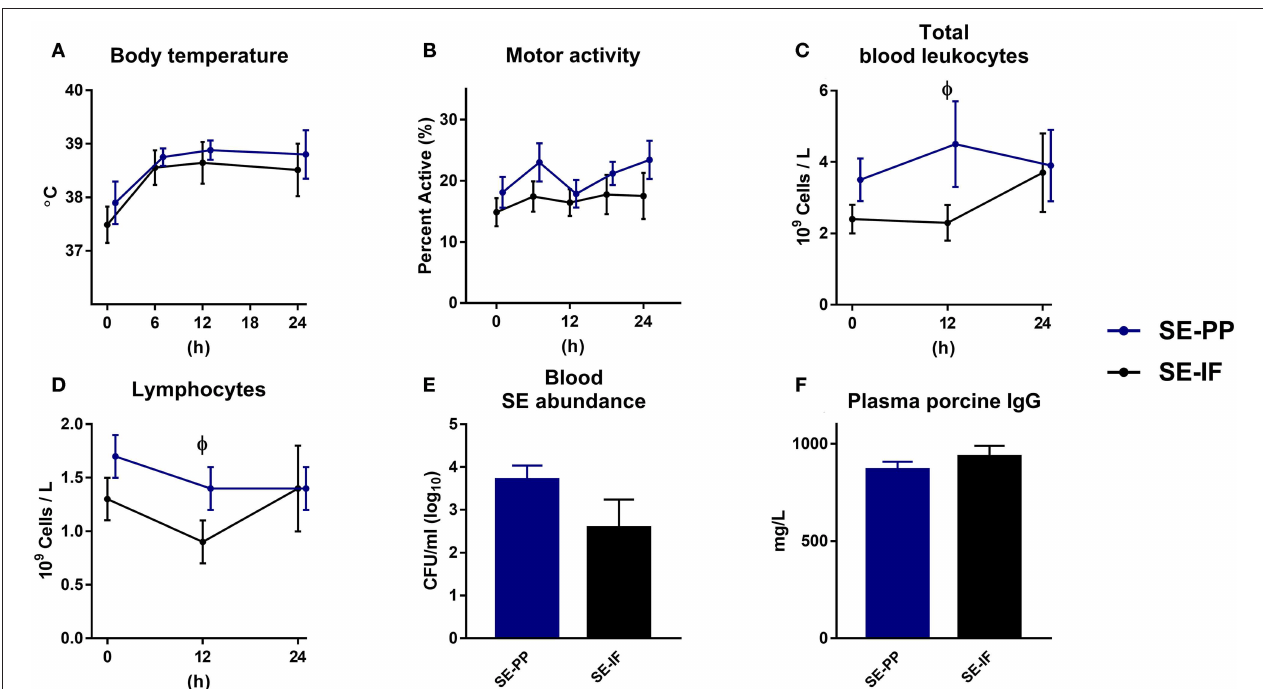
FIGURE 5 | Feeding of infant formula, enriched with porcine plasma, has no effect on responses to Staphylococcus epidermidis bacteremia. Results of Experiment 5 where preterm pigs were infused with Staphylococcus epidermidis (SE) on day 4, after infusion of maternal plasma at birth, and then fed infant formula supplemented with porcine plasma powder (SE-PP) or whey protein (SE-IF). (A) Body temperature 0–24h post inoculation. (B) Motor activity, shown as the fraction of time with physical movements at 0–24h post inoculation. (C) Total blood leucocyte counts 0–24h post inoculation. (D) Lymphocyte counts in blood, 0–24h post inoculation (E) Abundance of SE in blood at euthanasia, shown colony-forming units per milliliter of whole blood. (F) Plasma levels of porcine immunoglobulin G (IgG) at euthanasia. (A–F) Presented as means with corresponding standard errors. φ : Effect of PP ( p <